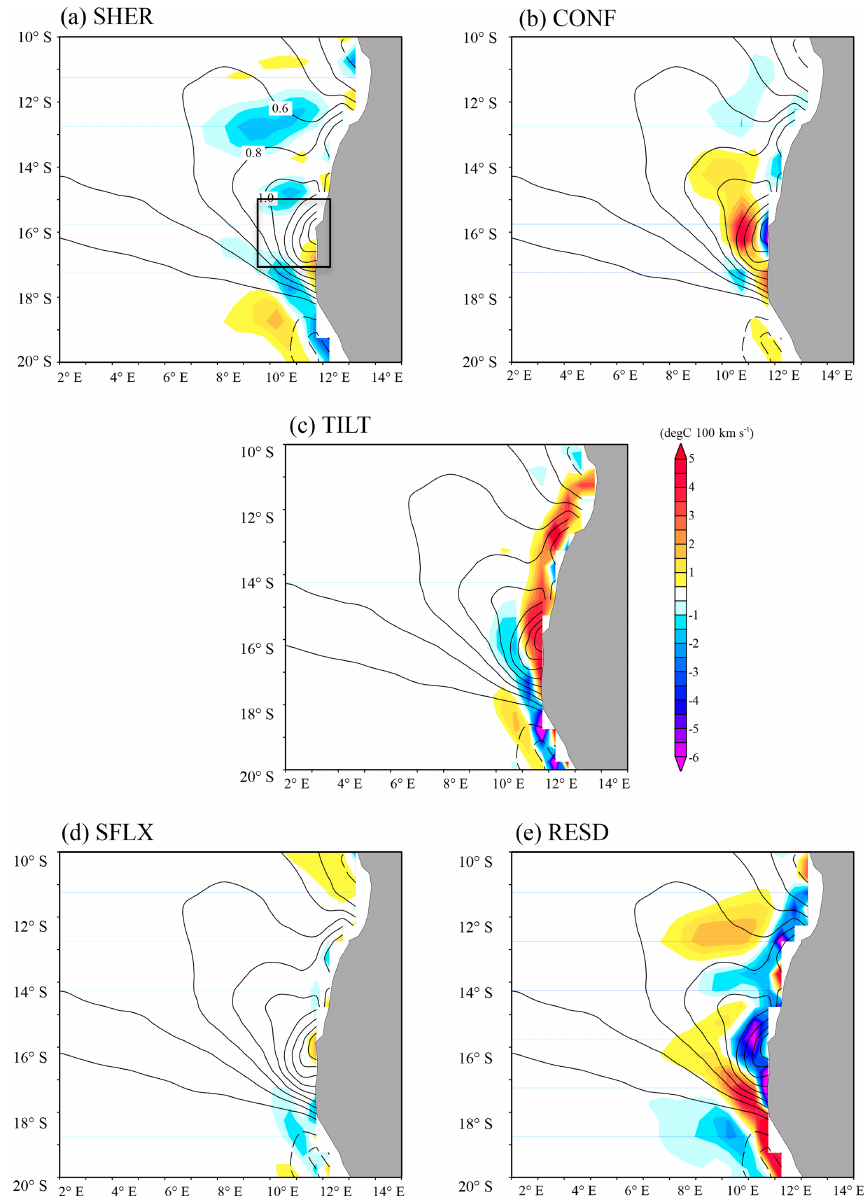
Figure 4. Annual-mean climatology of each term in OFGF. Contour is annual-mean climatology of meridional gradient of OML-mean potential temperature of CFSR ( ◦ C per 100km). The black box in (a) is the ABFZ used for the analysis in this